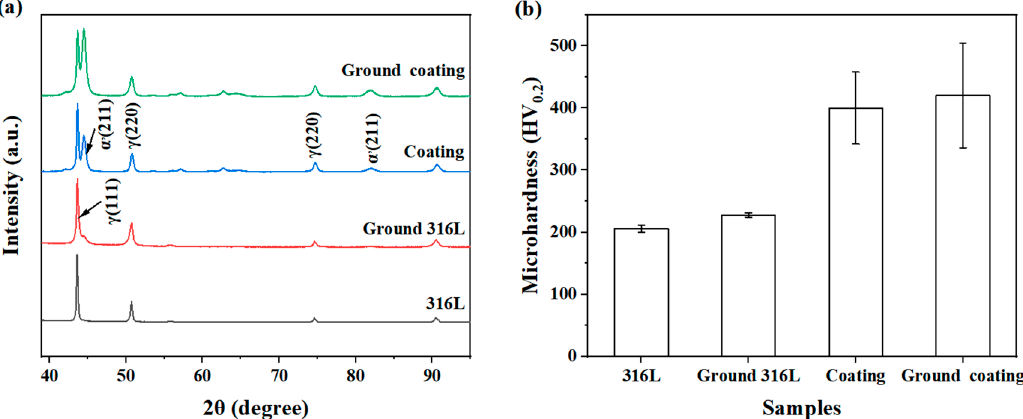
Figure 3. XRD patterns ( a ) and microhardness ( b ) values of the specimens before cavitation erosion.